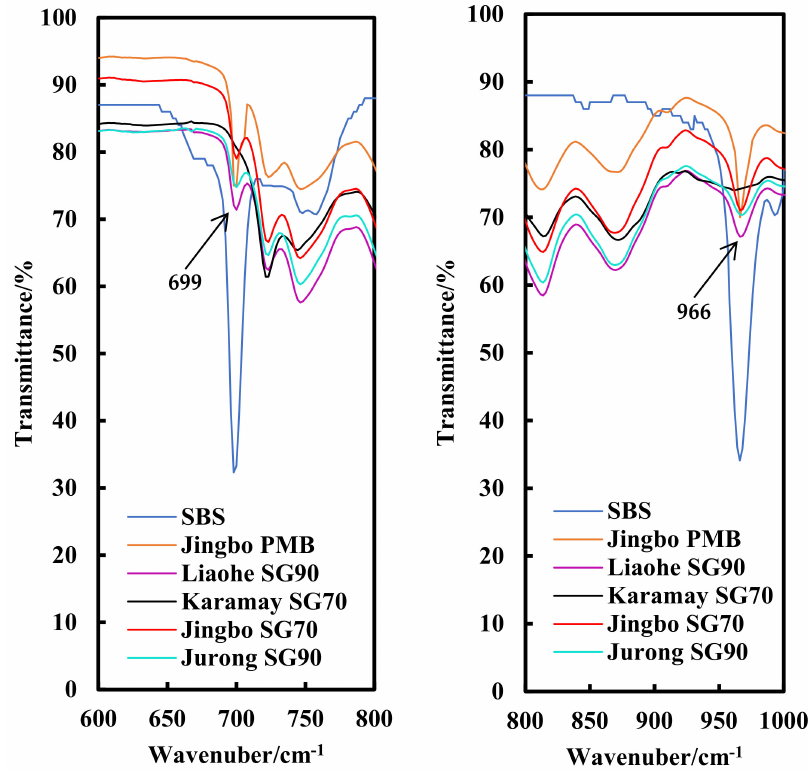
Figure 5. Infrared spectra of SBS and hydraulic bitumen binders.